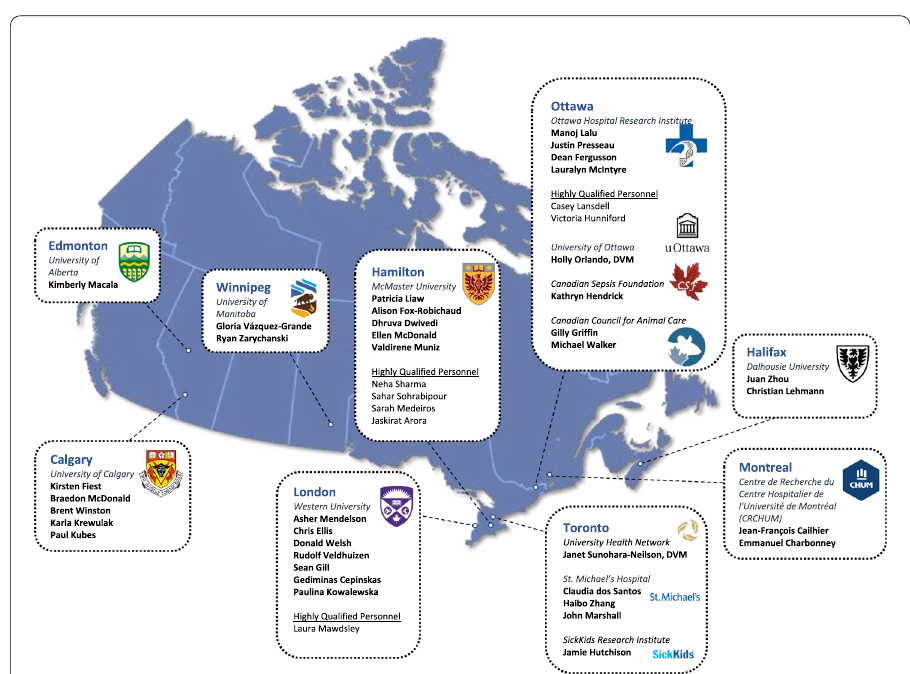
Fig. 2 Participants in the National Preclinical Sepsis